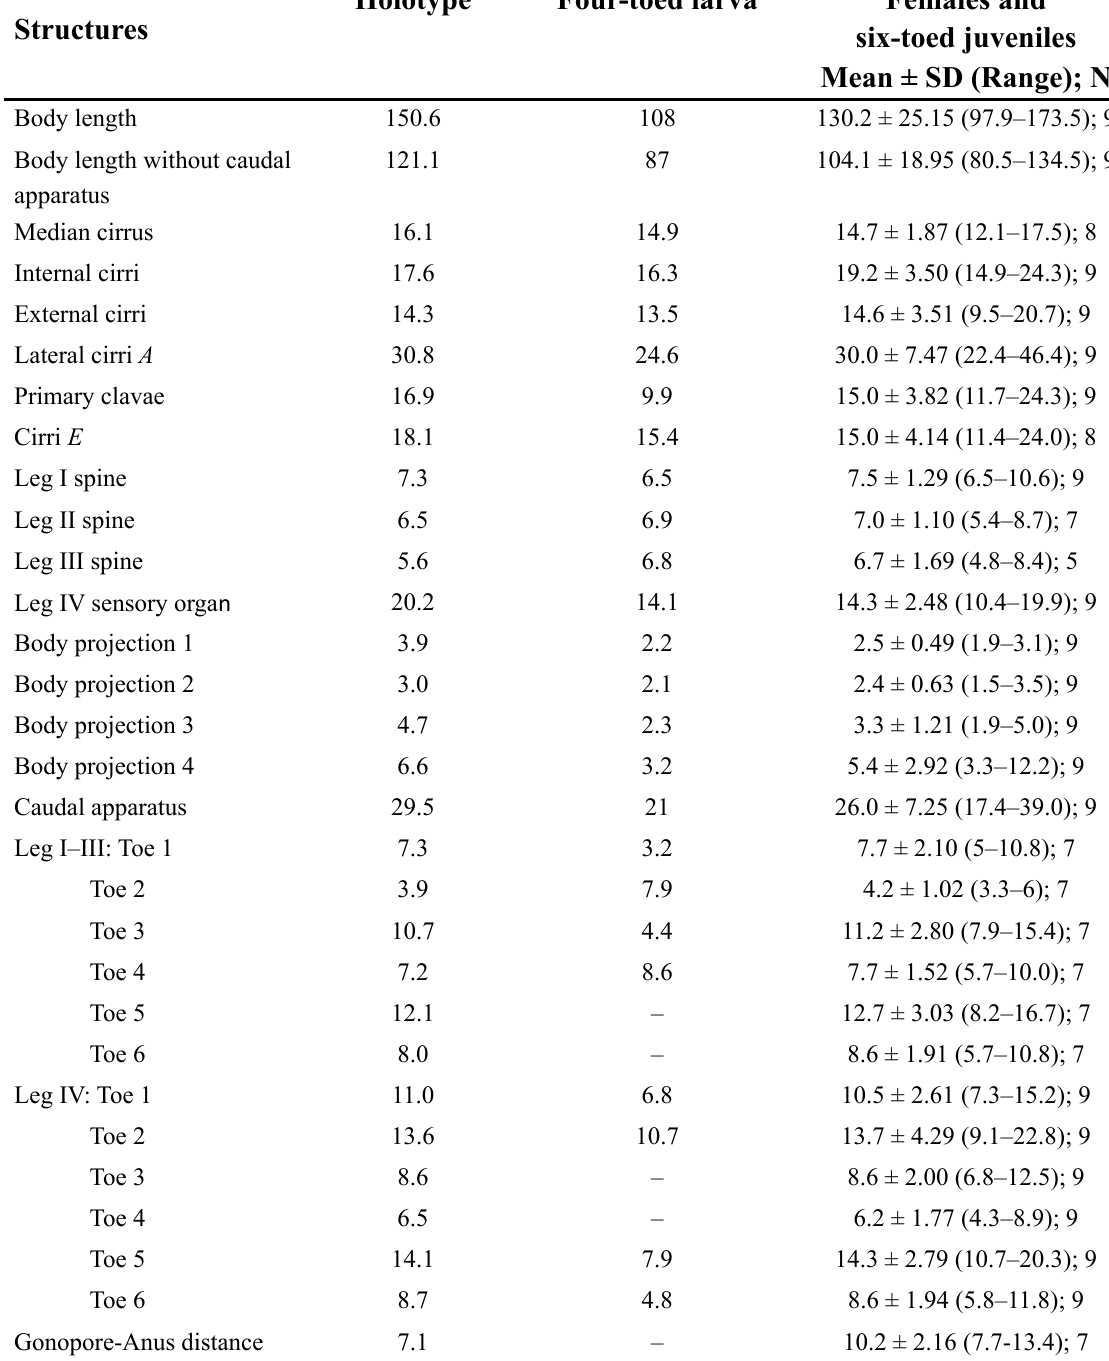
Table 1. Measurements (µm) of selected morphological structures from the holotype and paratype, a four- toed larva, of Batillipes algharbensis sp. nov. from Portugal, and specimens from galicia (NW Spain) (SD – Standard deviation; Range refers to the smallest and largest measured specimen / structure; N - number of specimens / structures